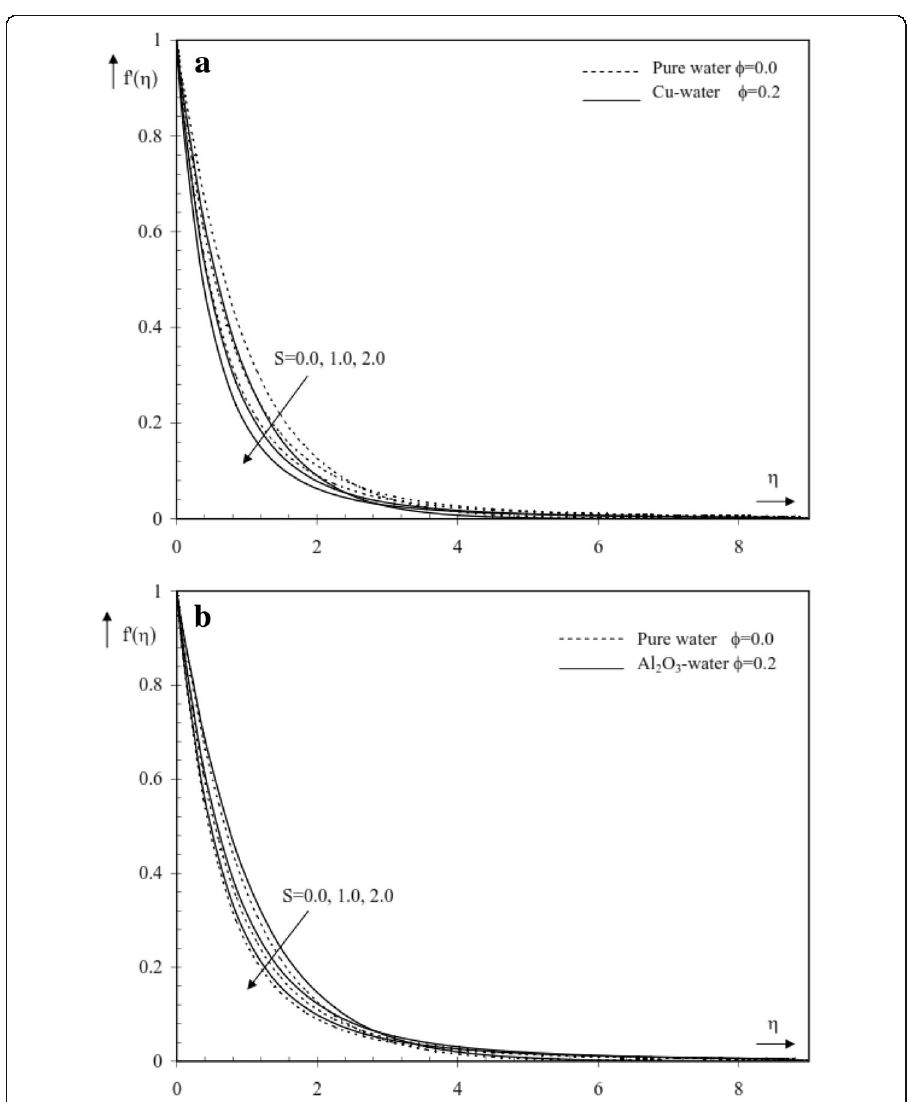
Fig. 15 Effects of ϕ and S on velocity distribution f ′ ( η ) for f w = M = 0.1 and A = B = λ = 0.5 for a Cu-water and b Al 2 O 3